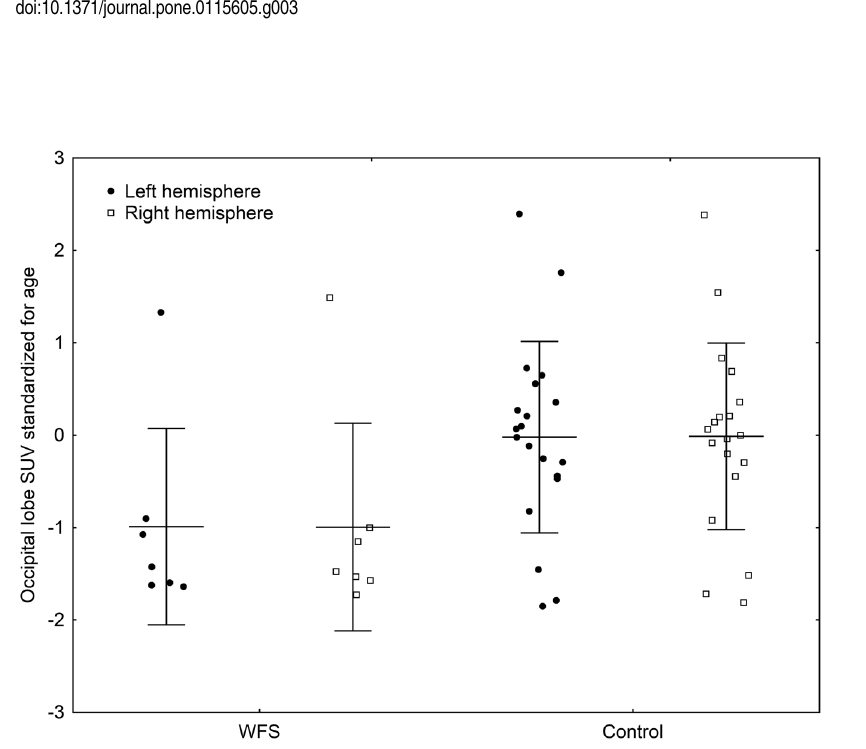
Fig. 4. Mean SUV and SD values (standardized for age) for the right and left occipital lobes in WFS and control